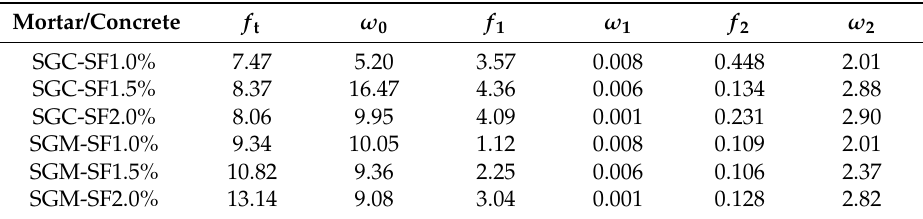
Table 8. Trilinear softening curve parameters of steel fiber-reinforced SGM/SGC.